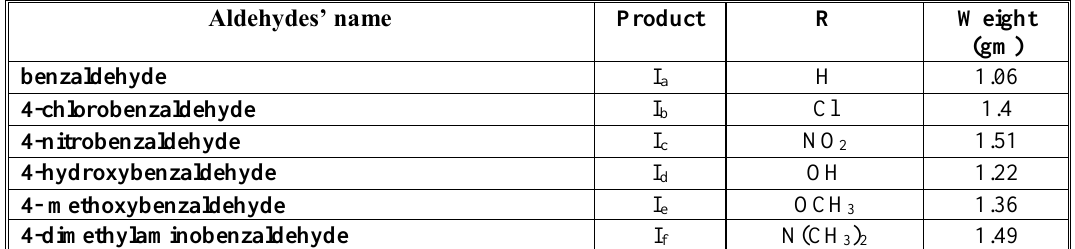
FT-IR: 3213 (OH stretching), 3070 (asymmetric CH stretching aromatic), 3032 (symmetric CH stretching aromatic), 1647 (C=O), 1597, 1554 (C=C aromatic), 1346 (OH bending), 1215